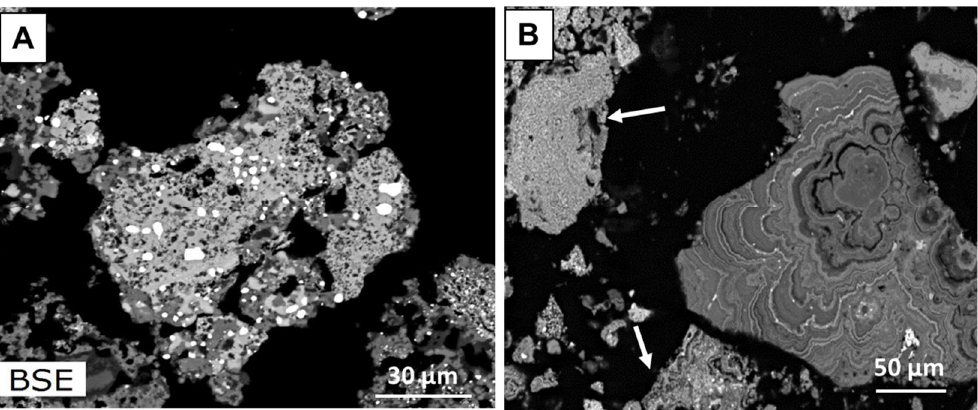
Figure 4. ( A ) Backscattered electron (BSE) image of a transformed nodule fragment of sample P3 (element mappings in Figure 5). ( B ) BSE image of a non-transformed nodule fragment of sample P1. Individual growth structures can still be recognized. Around the original fragment transformed fragments can also be recognized (marked with an arrow).